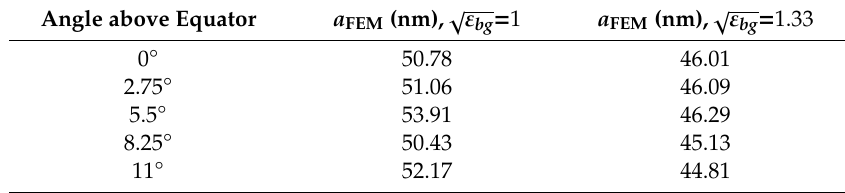
Table 1. Particle sizing for nanospheres on the rim of the microtoroid with di ff erent angles in yz -plane. The simulated nanosphere has a radius of a 0 = 50 nm. The percent errors in size are 0.86–7.82% and